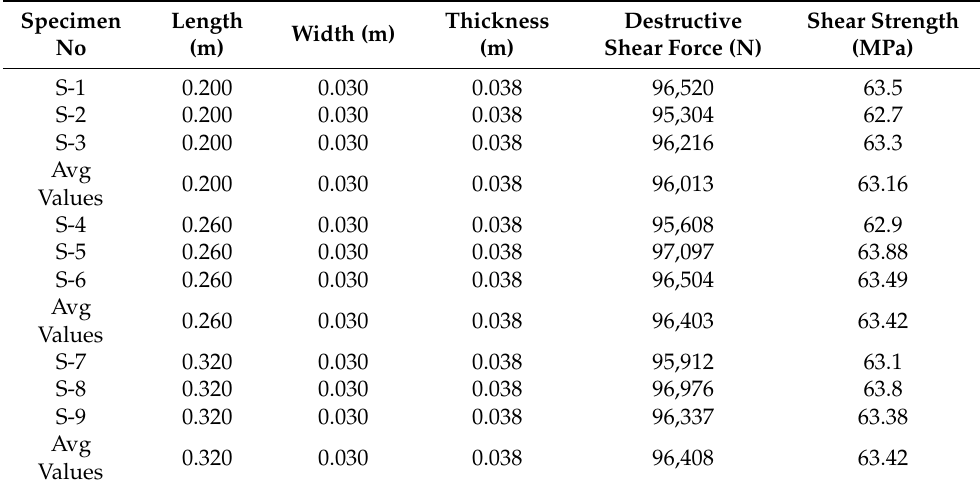
Table 8. Experimental evaluation of shear strength of thick